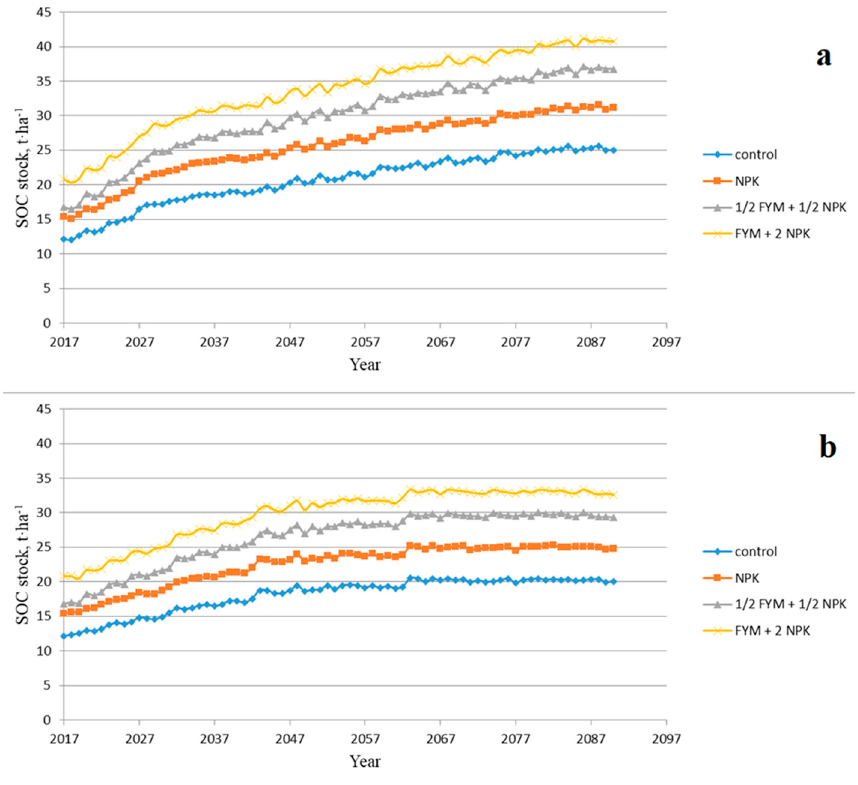
Figure 5. The dynamics of total SOC stocks predicted by the RothC model for 2017–2090 under the RCP4.5 ( a ) and RCP8.5 ( b ) climate scenarios. RCP4.5 ( a ) and RCP8.5 ( b ) climate